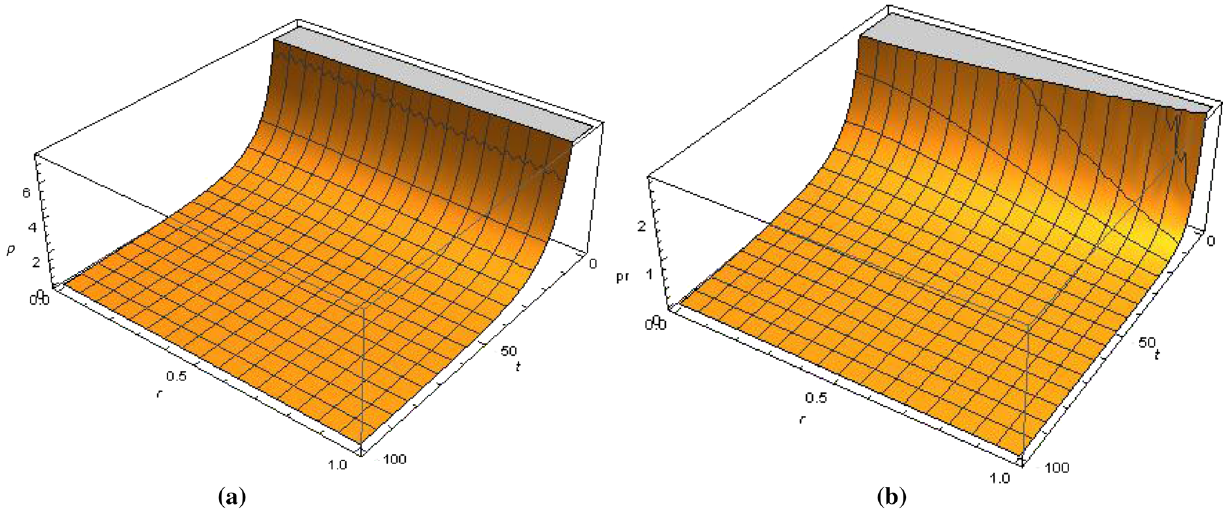
p r , Eq. (2.49), with respect to r at center r = 0 and at the surface of the star at r = 1. This plot shows that the radial pressure is positive as the collapse starts at t = − 100 and is maximum at the end state of the collapse at t = 0